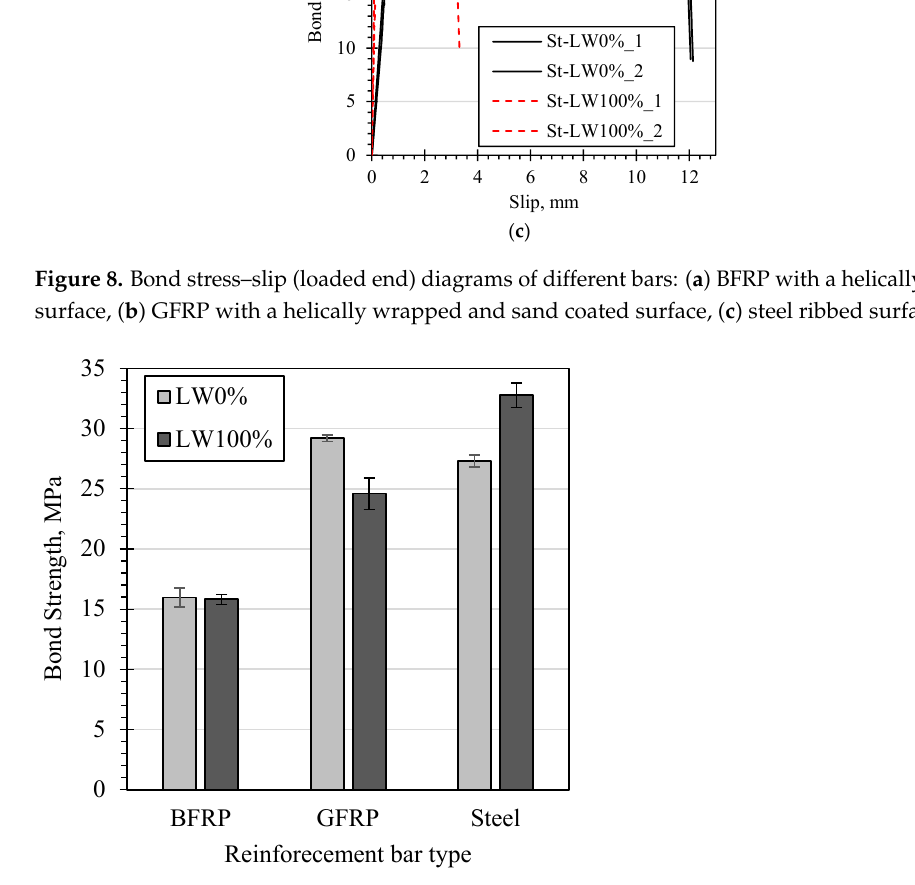
Figure 8. Bond stress–slip (loaded end) diagrams of different bars: ( a ) BFRP with a helically wrapped surface, ( b ) GFRP with a helically wrapped and sand coated surface, ( c ) steel ribbed sur- face.